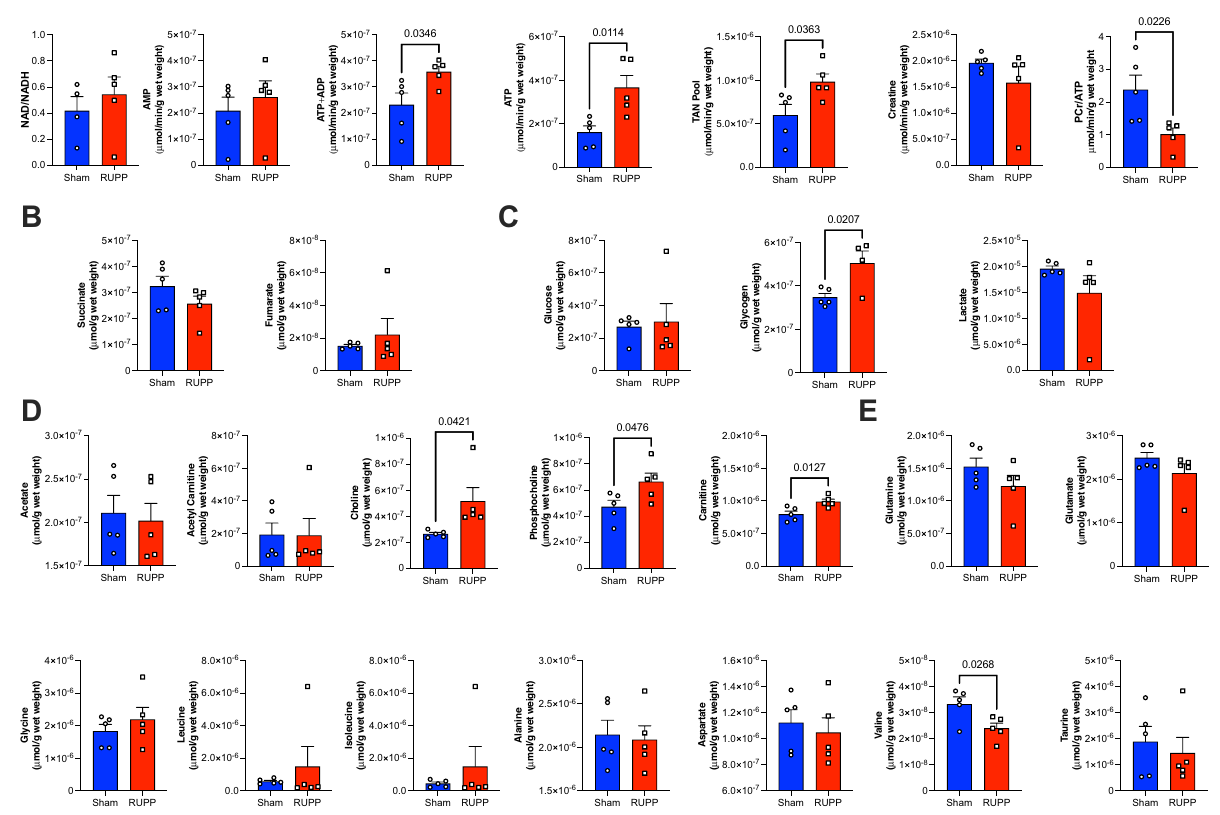
Figure 4. Impact of RUPP on placenta metabolism. Metabolite concentrations are grouped into ( A ) Redox and Energetics ( B ) TCA Cycle ( C ) Carbohydrate metabolism ( D ) Lipid metabolism ( E ) Amino acid metabolism. Two group comparison was carried out using the student T test (normally distributed data) or Mann-Whitney U test (non-normally distributed data: fumarate, leucine, isoleucine, lactate, glucose) TAN-total adenine nucleotide pool (AMP + ADP + ATP). n = 5/group. PCr-phosphocreatine. P values < 0.05 shown in individual